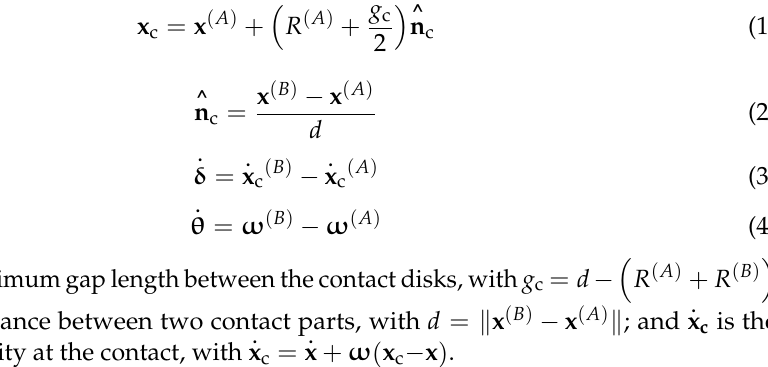
shown in Figure 3.